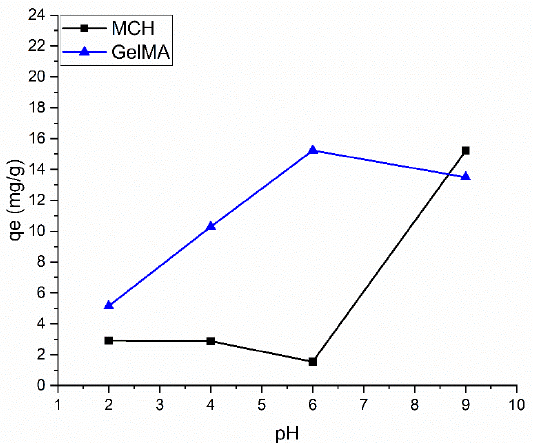
Figure 9. Effect of pH on hydrogel Pb adsorption. Those data were recorded with 30 mg/L Pb initial concentration.